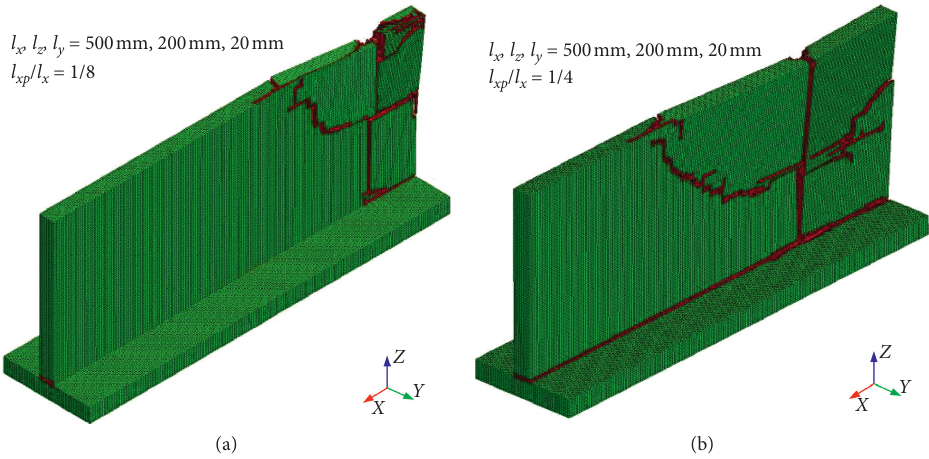
Figure 18: Cutting results of rock plate at different cutting positions: (a) l